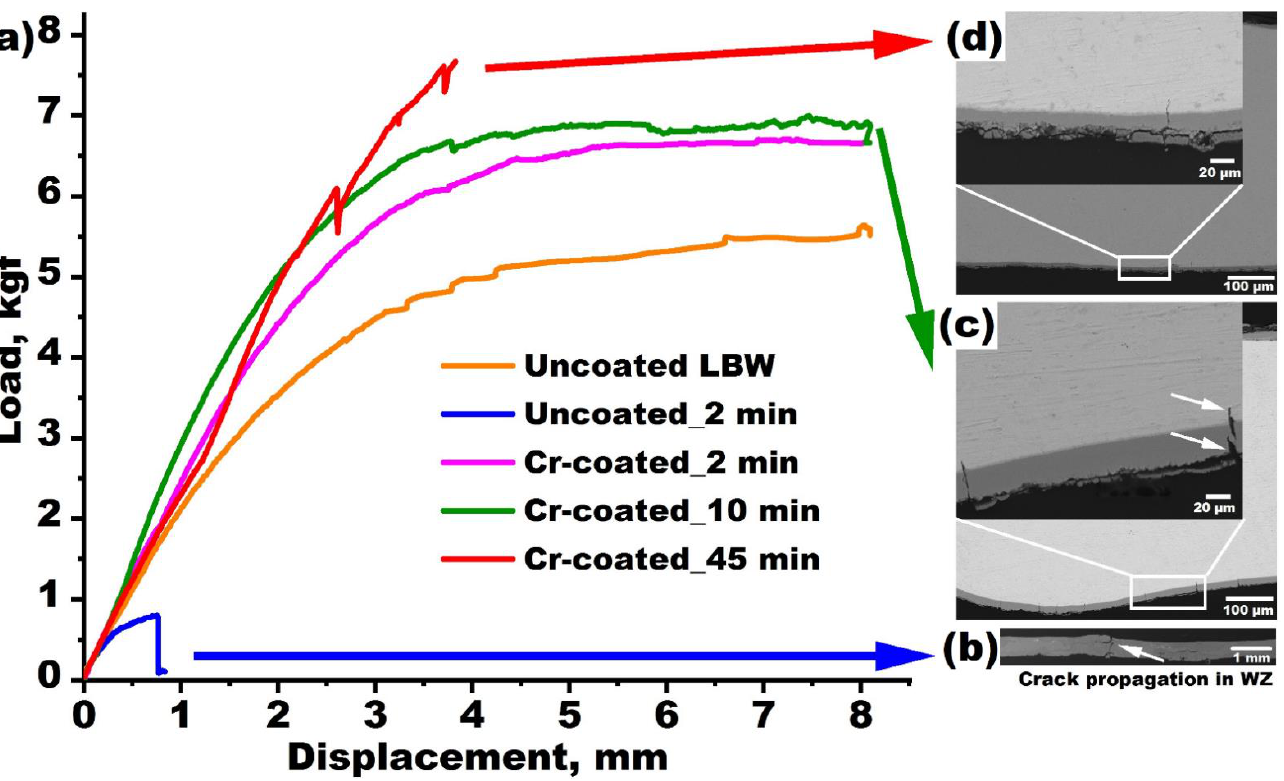
Figure 5. Load-displacement curves for uncoated and Cr-coated LBW E110 alloy samples ( a ). Insets show cross-section microstructure SEM images of the samples in WZ after bending tests: ( b )—uncoated LBW after 2 min oxidation; ( c )—Cr-coated LBW after 10 min oxidation; ( d )—Cr-coated LBW after 45 min oxidation.